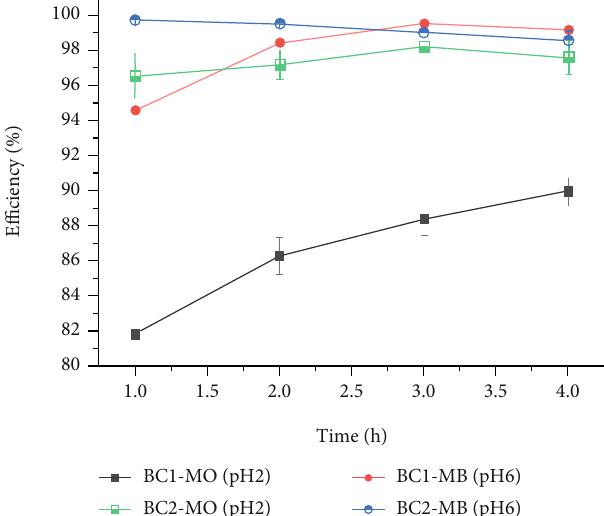
Figure 15: E ff ect of two di ff erent biochars on adsorbability of dyes molecules.